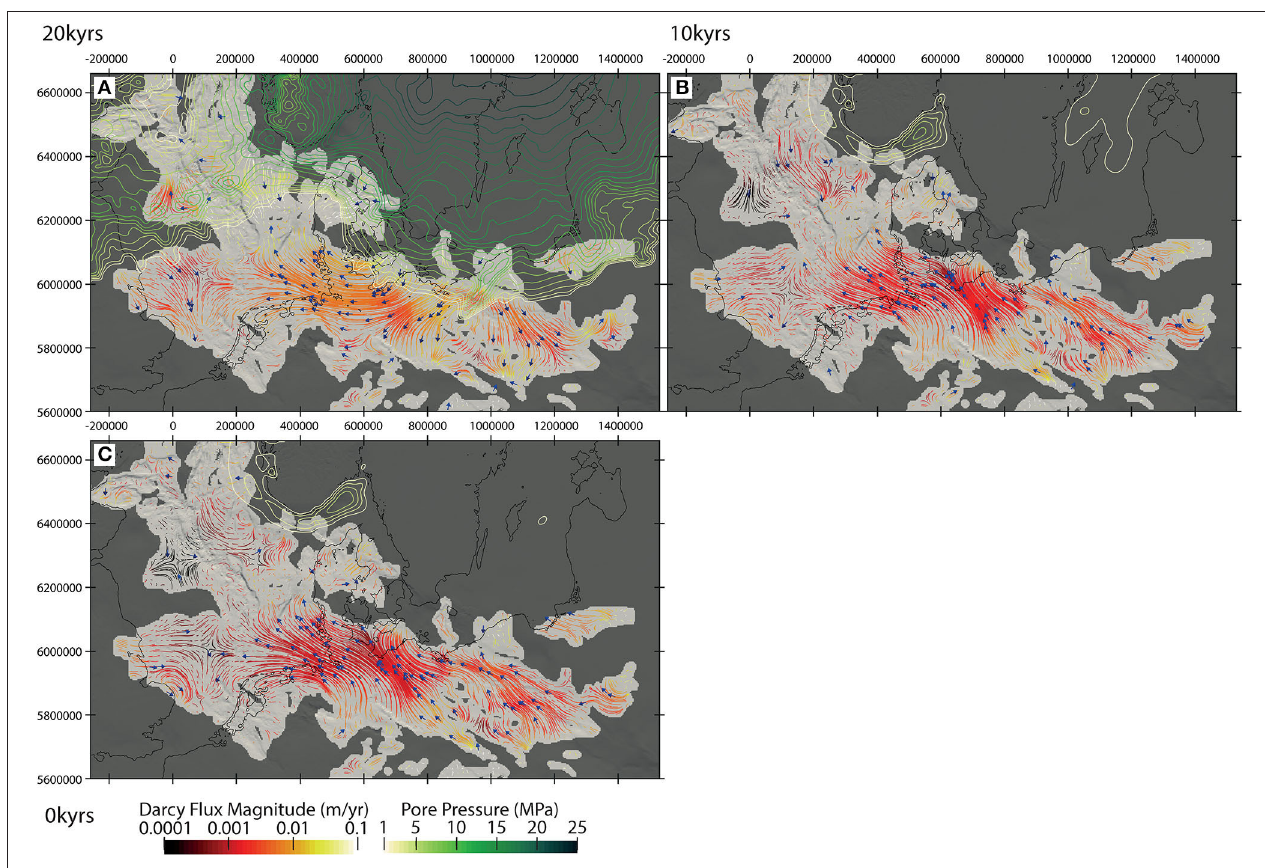
FIGURE 5 | Fluid flow paths for the Rotliegend and pressure at the top of the model for selected time-steps, (A) − 20 kyrs, (B) − 10 kyrs, (C) 0 kyrs, and (A–C) bright gray colors = extent of Rotliegend aquifer, dark gray = underlying basement, blue arrows = fluid flow direction projected in 2D. Coordinates are in UTM Zone